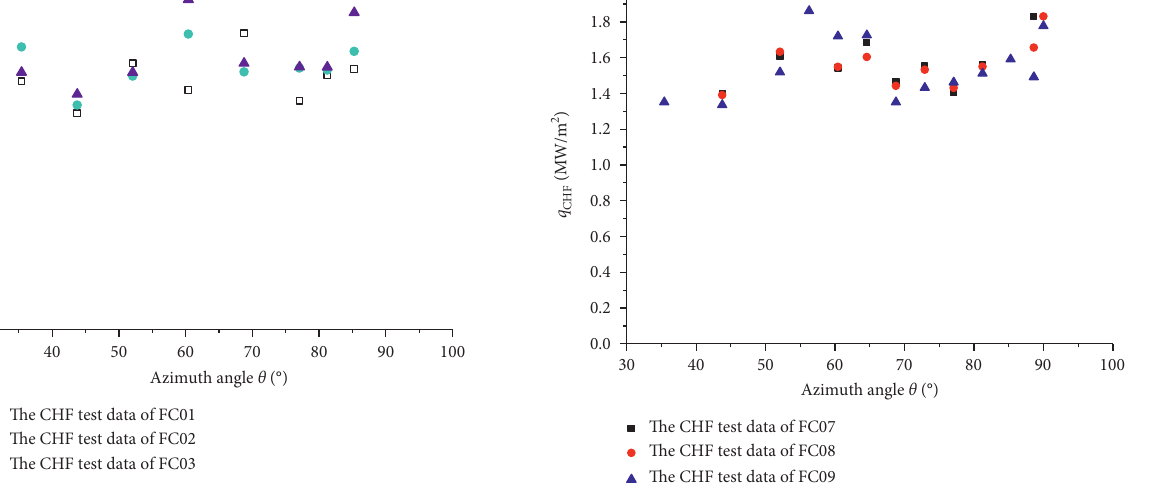
Figure 9: CHF distribution of the FC07-FC09 test